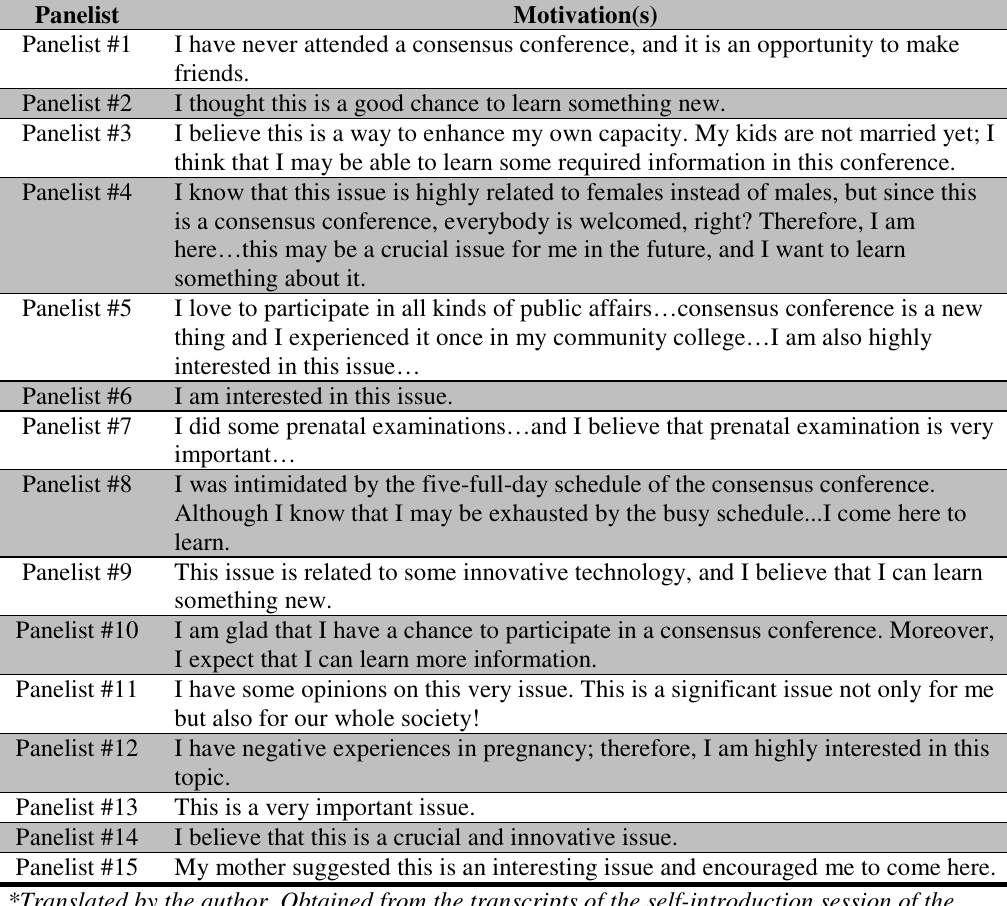
Table 1: Motivation(s) to apply for attending this consensus conference Panelist